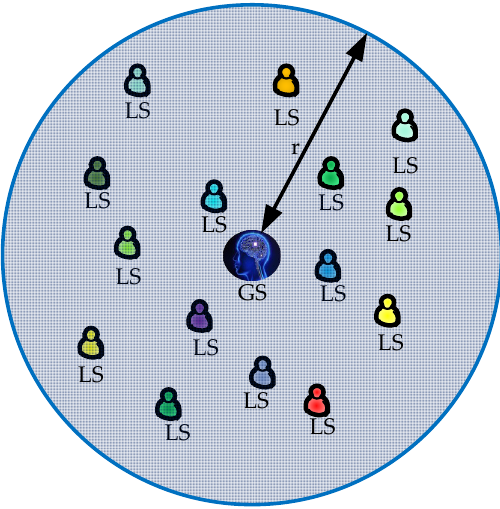
Figure 3. Double-layer searcher search area.